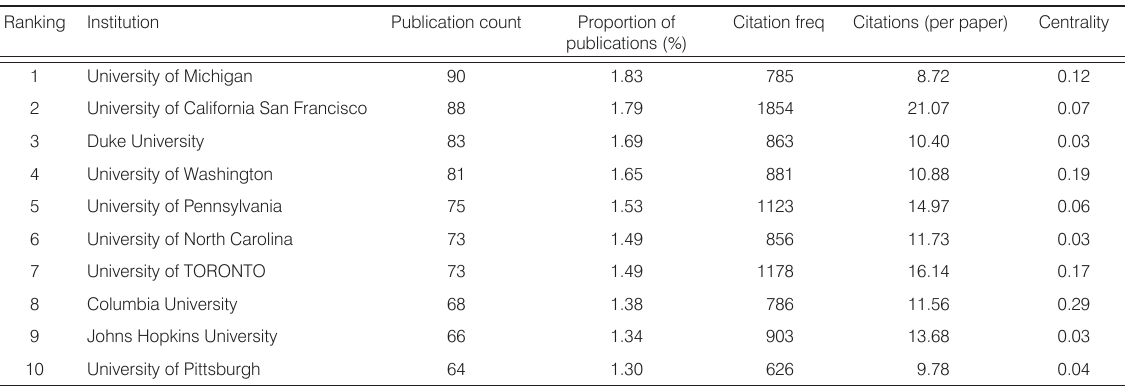
Table 2. Publication and citation frequency of the top 10 productive institutions.